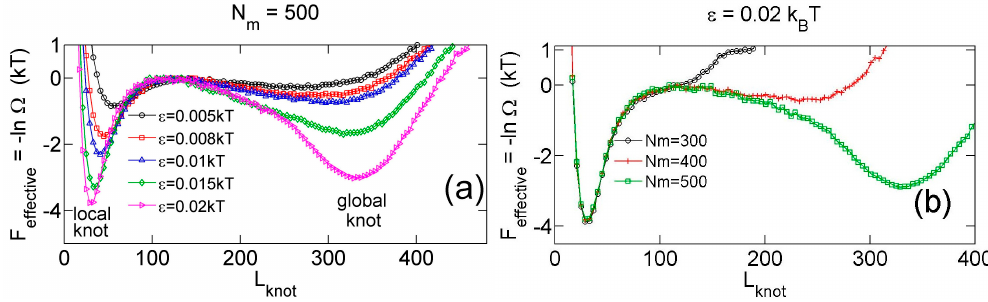
Figure 3. ( a ) Effective potential as a function of the knot size for various strengths of triangle potentials obtained from simulations with fixed N m = 500 and fixed R int = 10 σ . ( b ) Effective potential as a function of the knot size for various sizes of ring chains obtained from simulations with fixed (cid:101) = 0.02 k B T and fixed R int = 10 σ